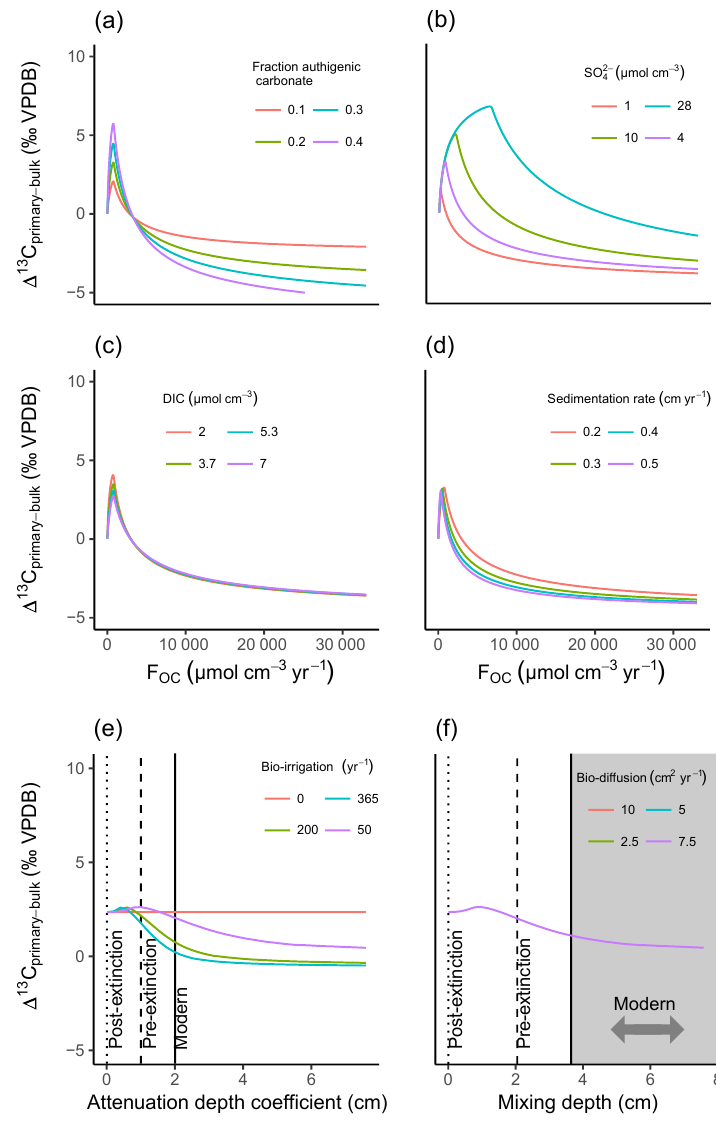
Figure 6. Sensitivity experiment for authigenic carbonate addition through sea-floor cementation designed to investigate the forcing effect of (a) the fraction of authigenic carbonate ( f auth ) incorporated, (b) sulfate content of overlying water, (c) DIC content of overlying water and (d) sedimentation rate ( v and w ) on the carbon isotope offset between the diagenetic end-member rock and the primary calcite over a range of F OC . Panels (e) and (f) depict sensitivity experiments for bio-irrigation ( α 0 ) and bio-diffusion ( D b0 ), respectively, on authigenic carbonate addition for changing modes of sediment reworking and irrigation by biota under a normal OC flux (730µmolcm − 3 yr − 1 ). An increasingly suppressed alteration of the end-member carbon isotope signal is observed for the pre-extinction (Dale et al., 2016) and modern (van de Velde and Meysman, 2016) depth profiles compared with sediment that is not inhabited by metazoans (post-extinction).